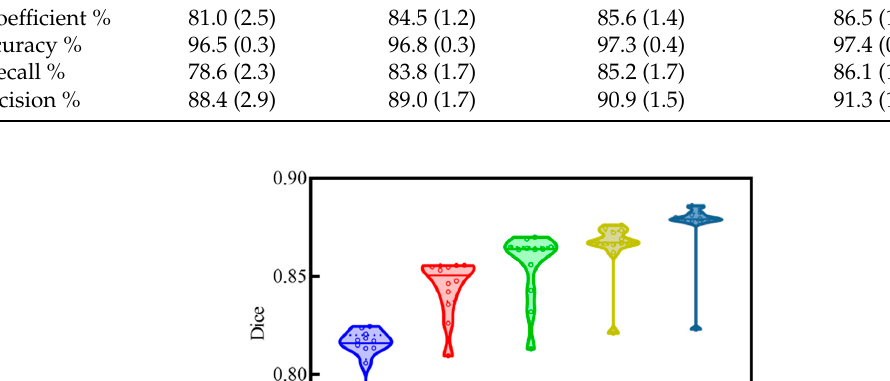
Figure 7. Violin plot of segmentation performance evaluation on different methods. Dashed line shows the 25th and 75th percentiles. The solid line represents the mean value. In this work, we evaluated the U-net (Res), U-net (DUC), U-net (DUC + HDC), and EVSegNet.